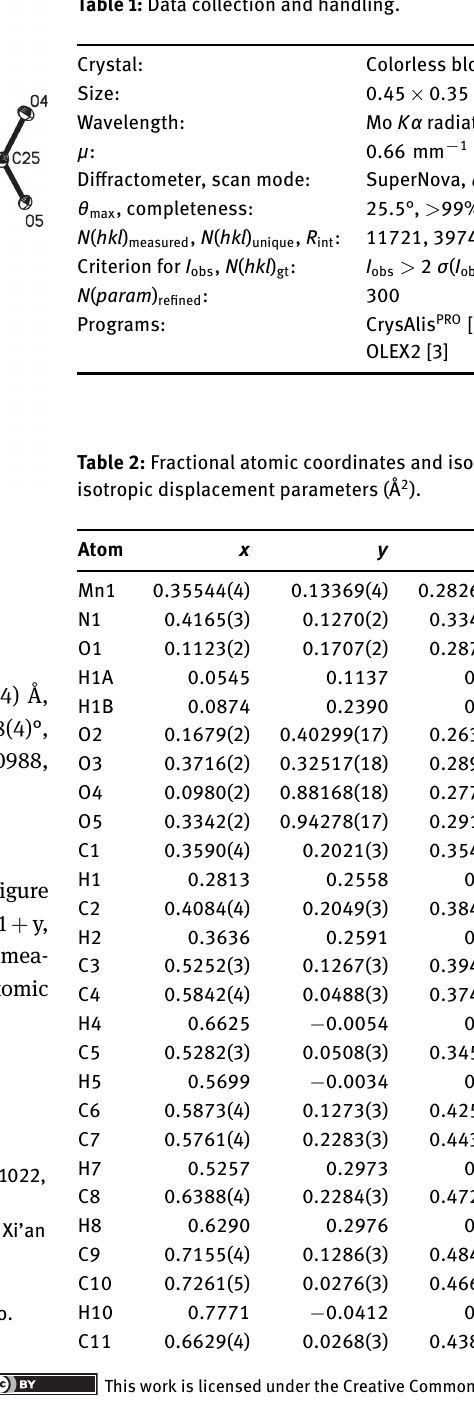
Table 1: Data collection and handling.